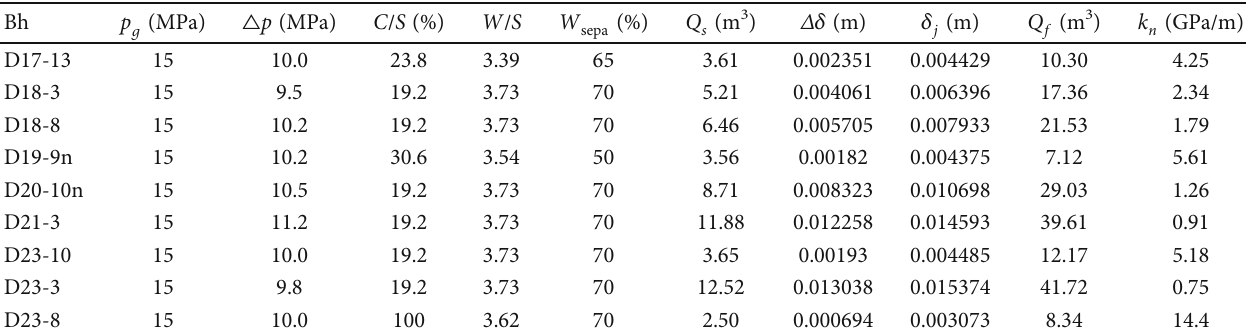
Table 4: Normal sti ff ness of fractures using the data of typical grouting